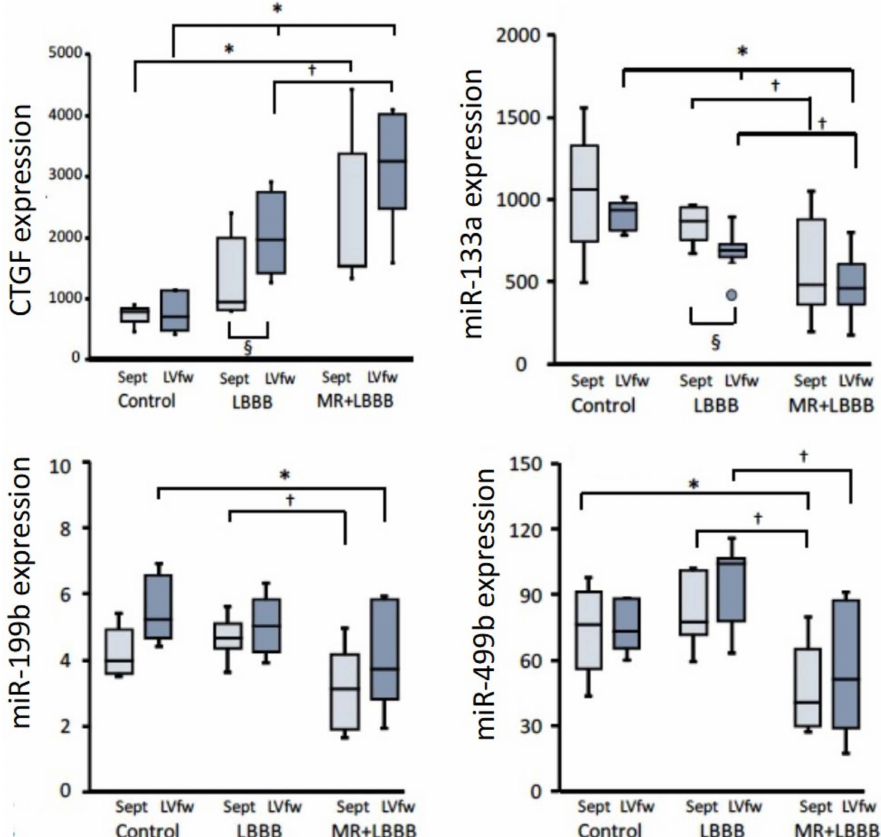
Figure 2. Boxplots of the expression of connective tissue growth factor (CTGF). and of microRNAs (miRs) related to hypertrophy. Dark blue boxes represent the LVfw and light blue boxes represent the septum. Data from 5 control, 8 LBBB and 8 MR + LBBB animals. * p < 0.05 vs. control; † p < 0.05 vs. LBBB; § p < 0.05 vs. septum using linear mixed-effect model analysis. Dashed lines indicate 100% (=median of control values in corresponding wall